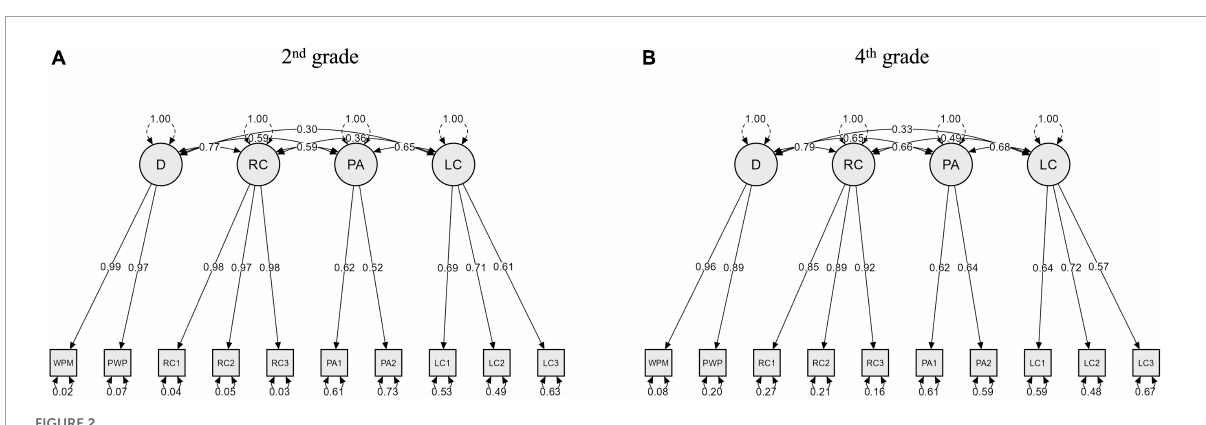
FIGURE2 Standardized parameter estimates for the (A) second and (B) fourth-grade children confirmatory factor analysis. D, Word recognition; RC, Reading comprehension; PA, Phonological awareness; LC, Language comprehension; WPM, Words per minute (correct); PWP, pseudowords per minute